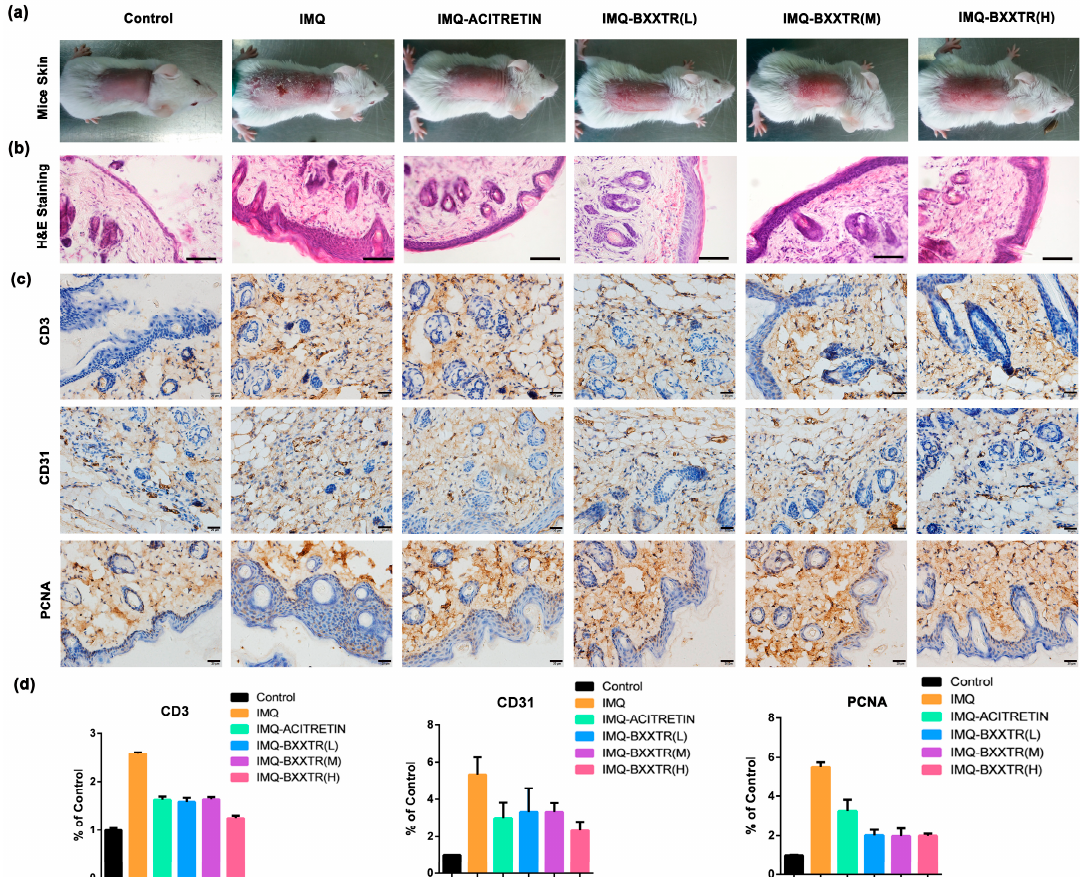
Figure 3. Presentation of the mice back skin phenotype, H&E staining and immunohistochemistry of sectioned skin. ( a ) Presentation of the phenotype of mice from the control group, IMQ group, IMQ-ACITRETIN group and IMQ-BXXTR group. The photograph is taken on day 6; ( b ) H&E-staining showed that IMQ-induced the back skin of mice showed dyskeratosis (nuclei in the stratum corneum) (Bar = 200 µ m), thickening of the stratum spinosum layer, vasodilation, subcutaneous hemorrhage, inflammatory cells in the dermis infiltration compared with the control group; ( c , d ) immunohistochemistry of different groups. Compared with IMQ group, IMQ-ACITRETIN group and IMQ-BXXTR group alleviated IMQ-induced psoriasis-like symptoms from varying degrees (Bar = 20 µ m).